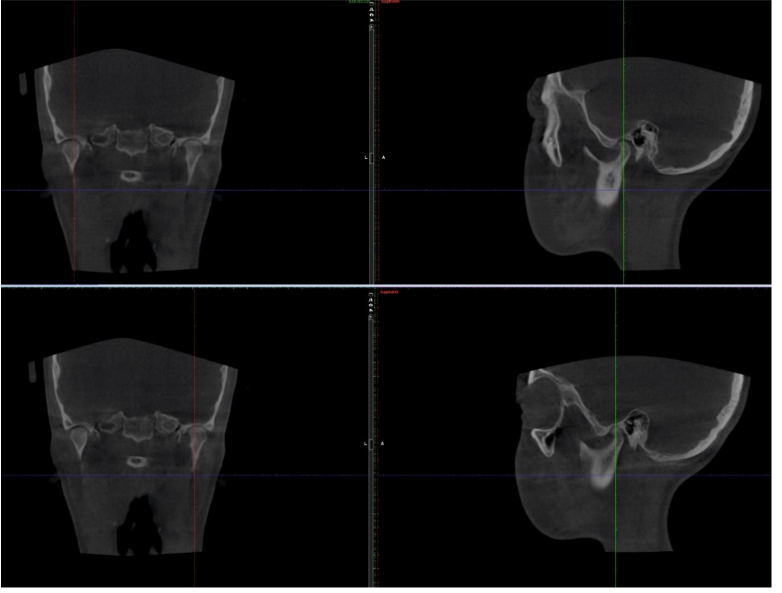
Figure 28. TMJ aspect on CBCT at the one-year follow-up